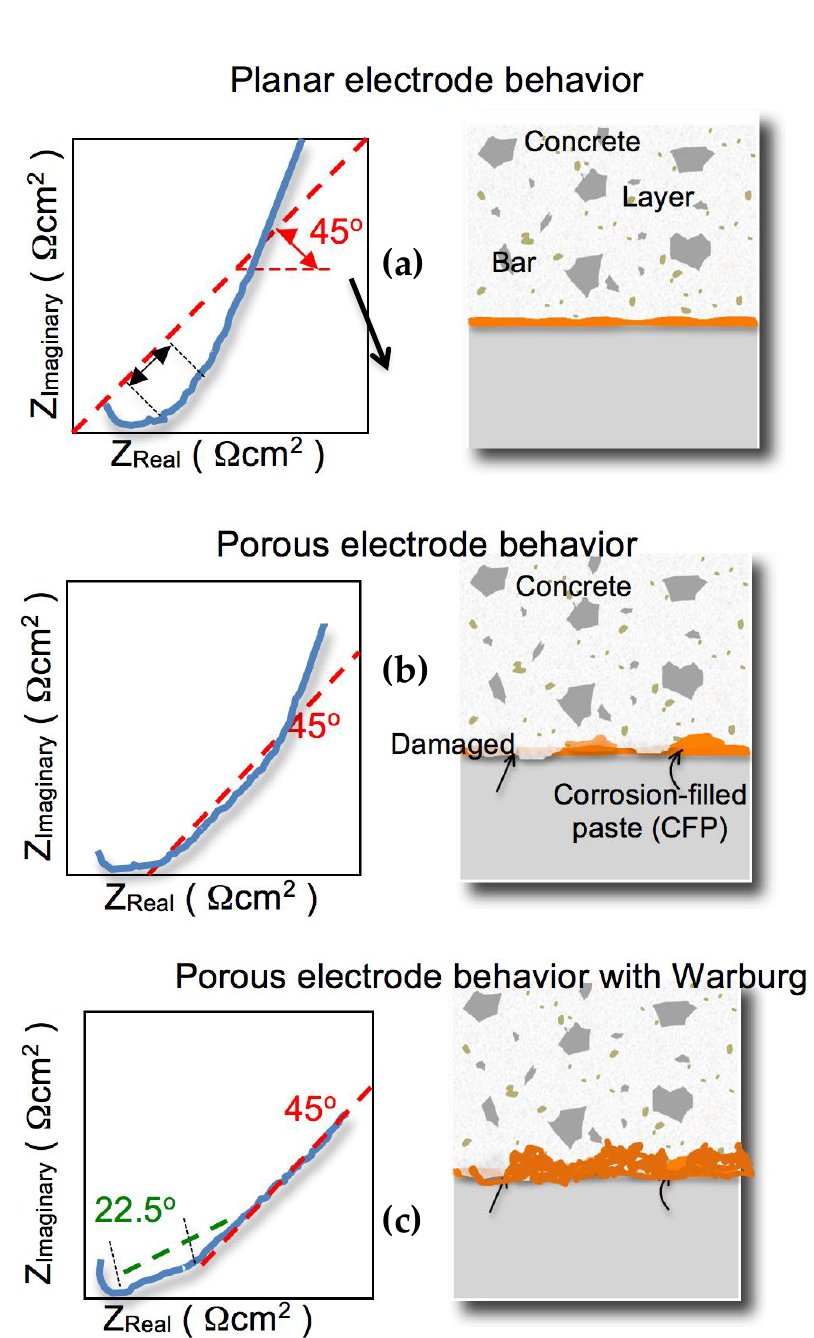
Figure 7. Schematic representations of the Nyquist plots and corresponding corrosion layer formation with predominant: ( a ) planar electrode behavior, ( b ) porous behavior and ( c ) porous with Warburg component formation.